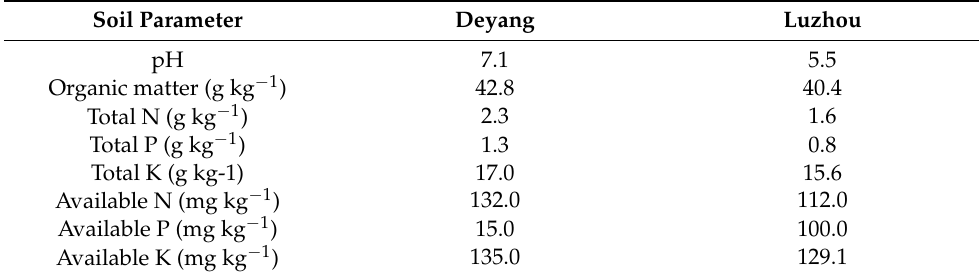
Figure 1. The two field experimental sites located in Deyang and Luzhou, Sichuan Province, China. Table 1. Soil properties of the experimental